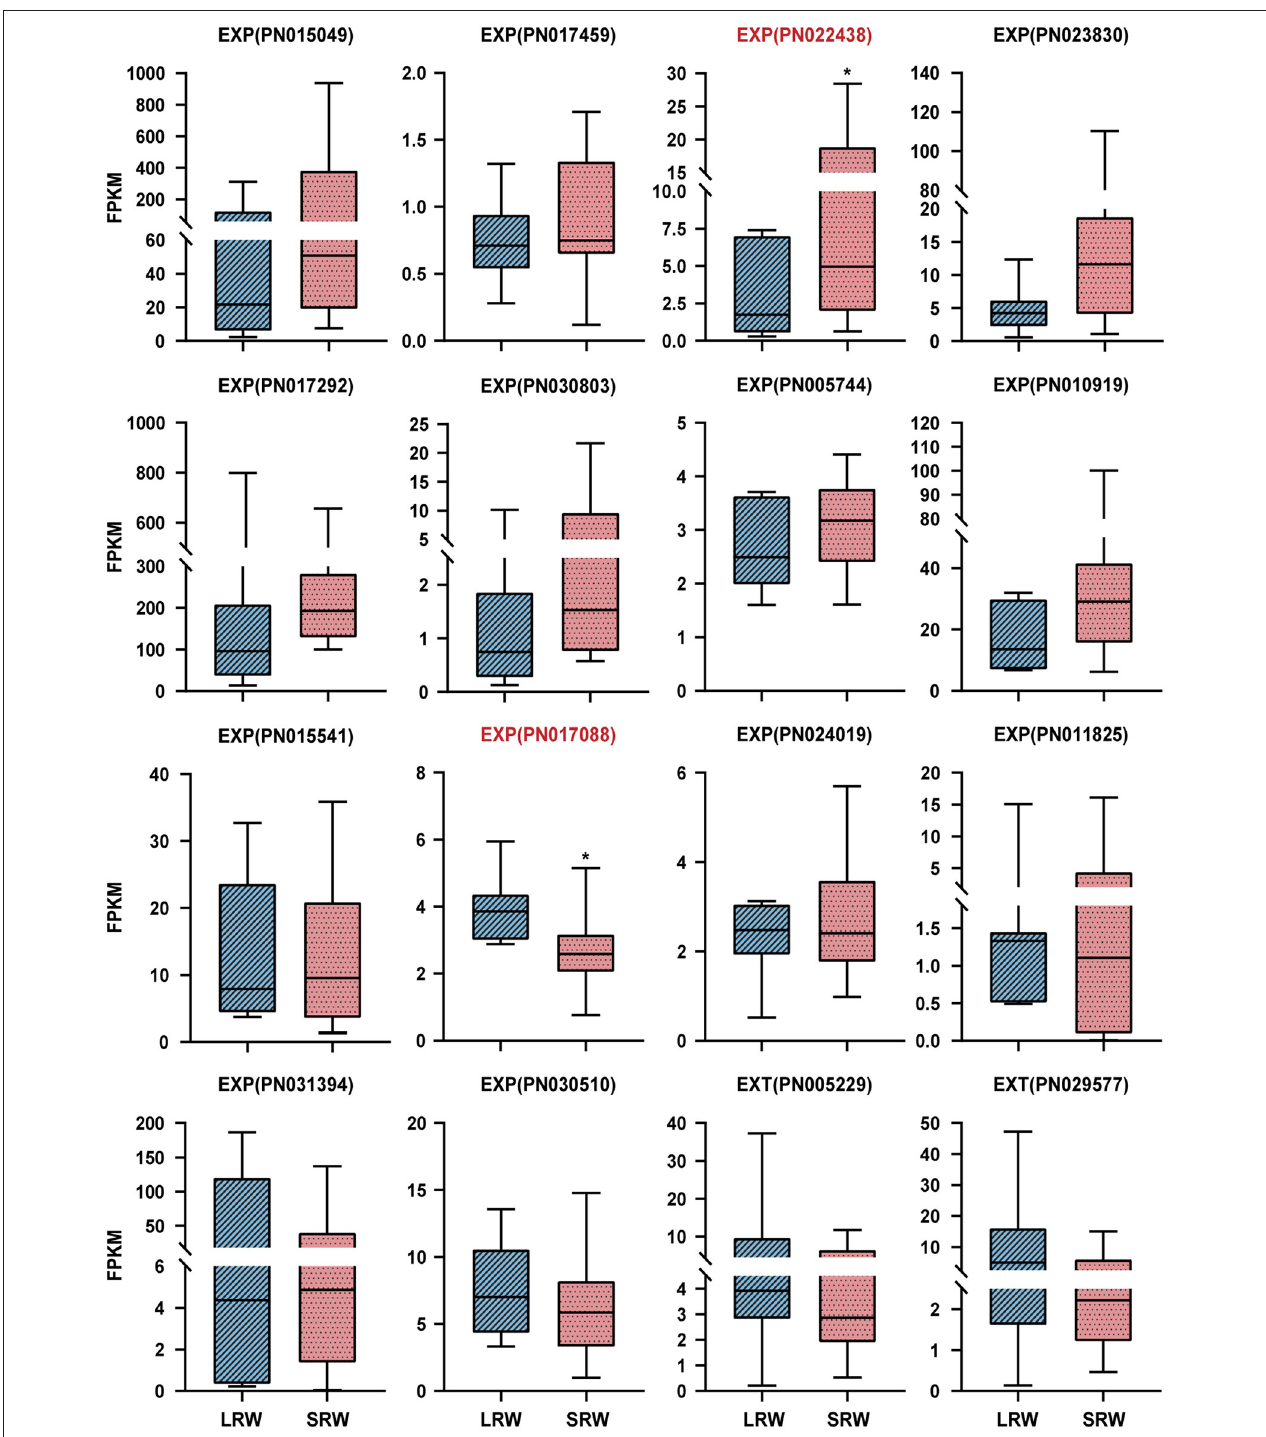
FIGURE 3 | Expression pattern of EXP s and EXT s in LRW and SRW samples. EXPA, alpha-expansin; EXPB, beta-expansin; EXT, extension. Asterisks denote student’s t- test significance: * P < 0.05. rate and then a bigger root size of P. notoginseng were